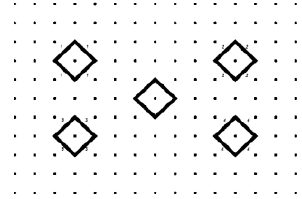
Figure 4. Test filed for Image Master Calib